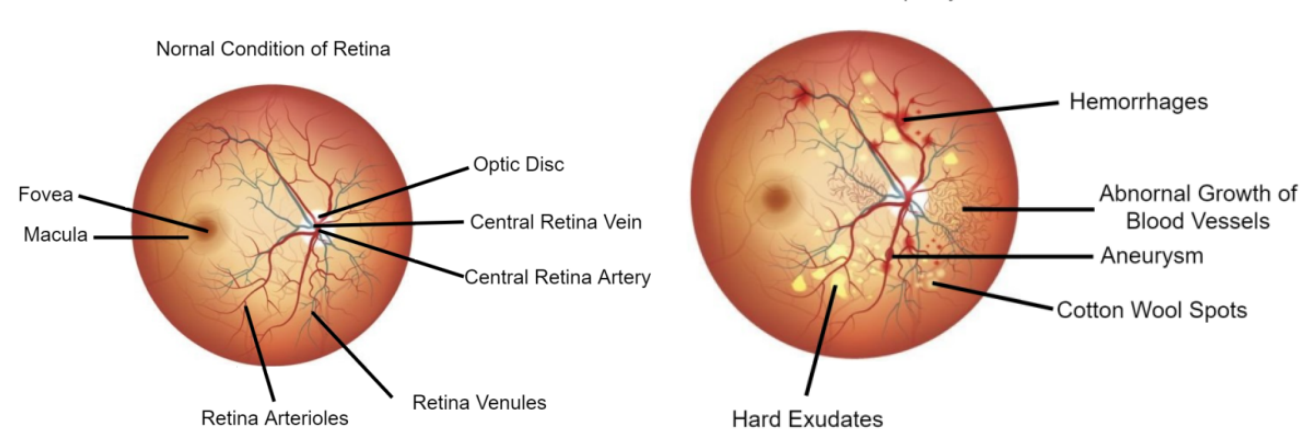
Figure 1. Visualization of a healthy retina and an unhealthy retina (https://neoretina.com/blog/ diabetic-retinopathy-can-it-be-reversed/, accessed on 1 August